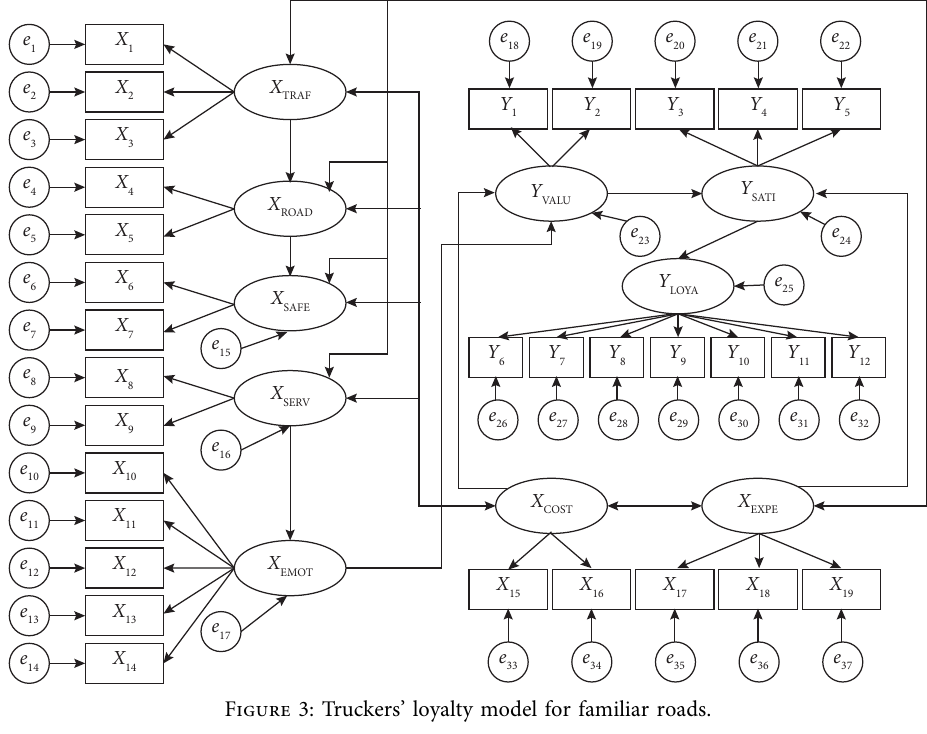
Figure 3: Truckers’ loyalty model for familiar roads.